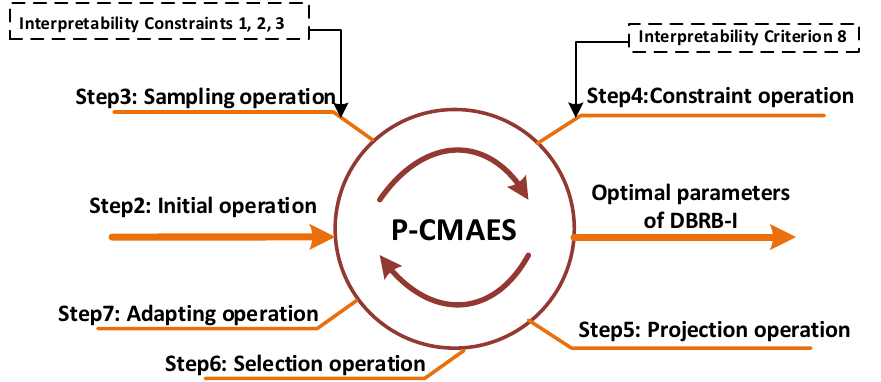
Figure 5. The optimization process of the modified